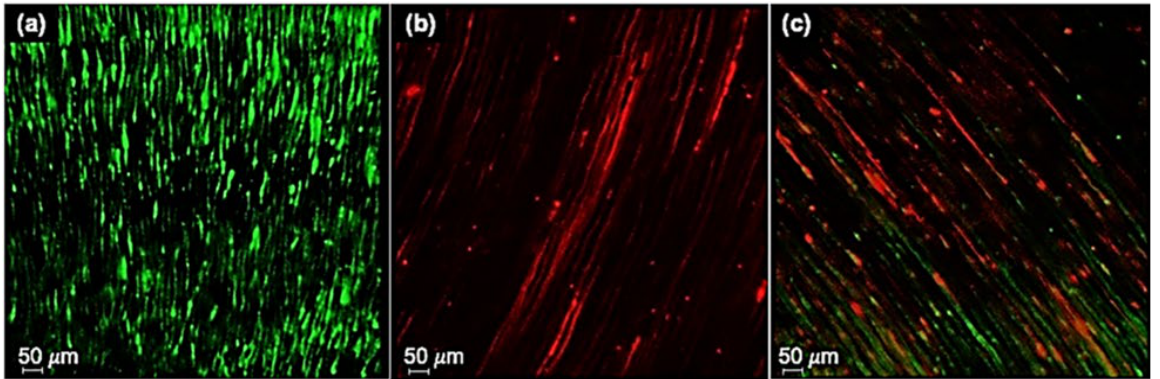
Figure 2. Representative images by CLSM of the untreated positive control and the two treatment groups. ( a ) Positive control: green fluorescence is evident, confirming extensive contamination with live bacteria. ( b ) NaOCl + citric acid 10% group: red fluorescence spots are predominant, indicating dead bacteria. ( c ) NaOCl + citric acid 1% group: some dots of green fluorescence can be identified, showing residual live bacteria, different from ( b ). Magnification × 40. Bars: 50.0 µm.